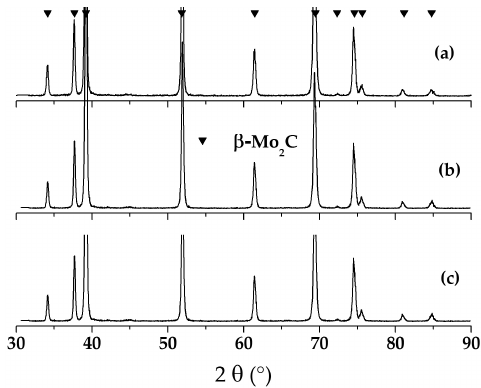
Figure 2. X ‐ ray diffraction (XRD) patterns of molybdenum carbide on molybdenum substrates with different shapes: ( a ) straight plate, ( b ) goffered plate, ( c ) wire. NaCl ‐ KCl ‐ Li 2 CO 3 (1.5 wt.%) ‐ Na 2 MoO 4